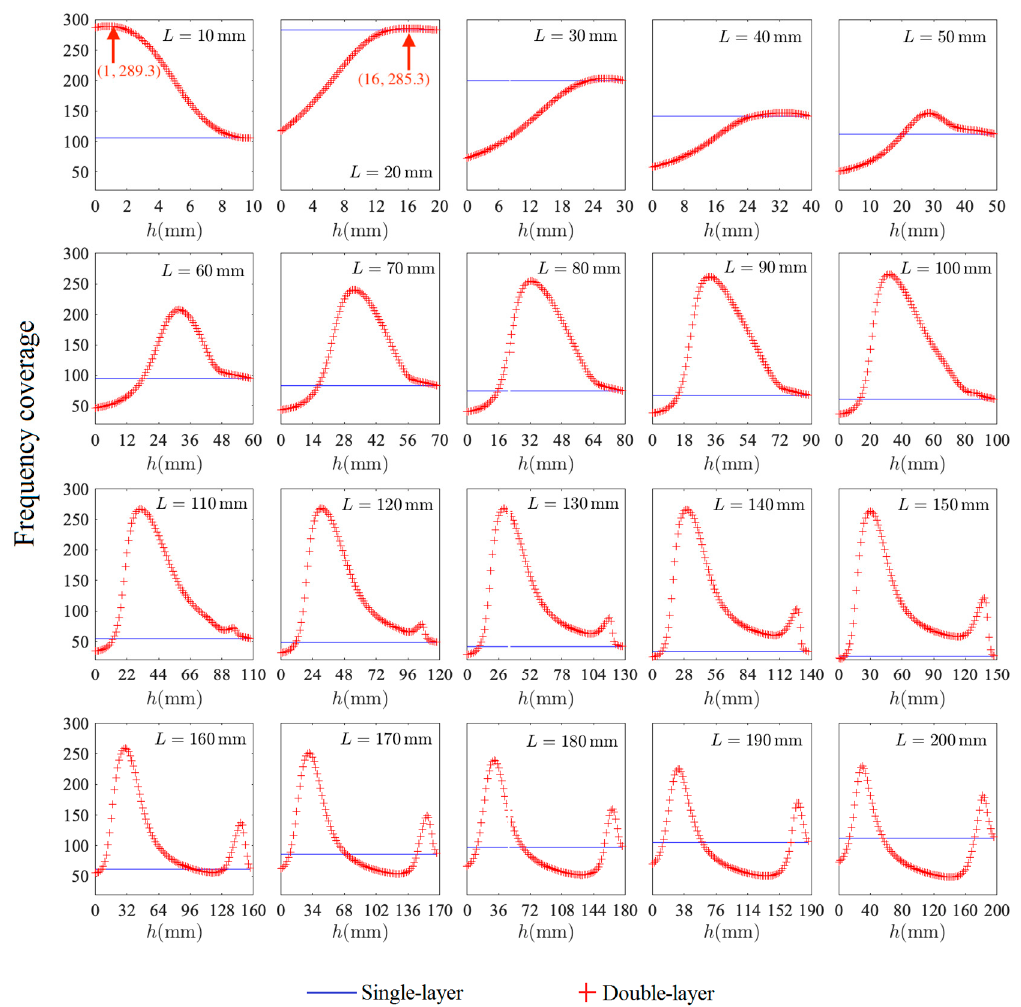
Figure 9. The frequency coverages of the single-layer and double-layer MPPs at each L varying from 10 mm to 200 mm.